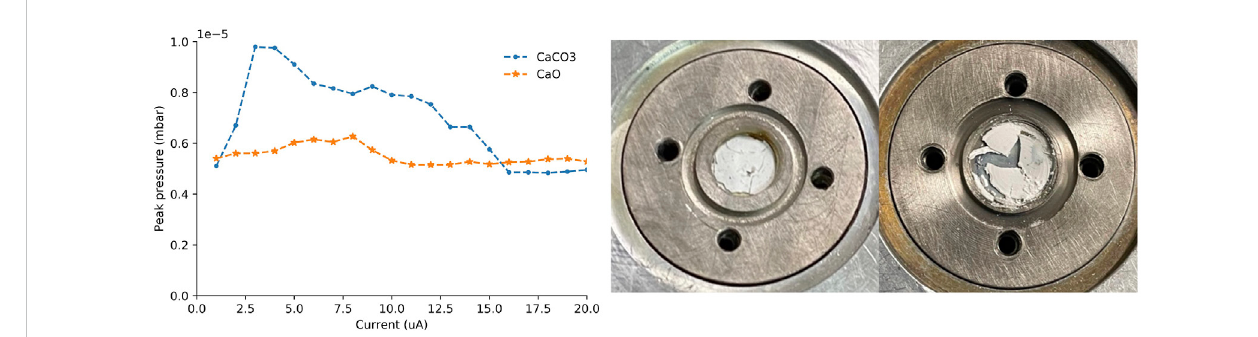
FIGURE 4 Peak pressure on the target as the current was increased (left). Pictures of the nat CaO (middle) and nat CaCO 3 (right) targets immediately following 0 – 20 µA proton irradiation.